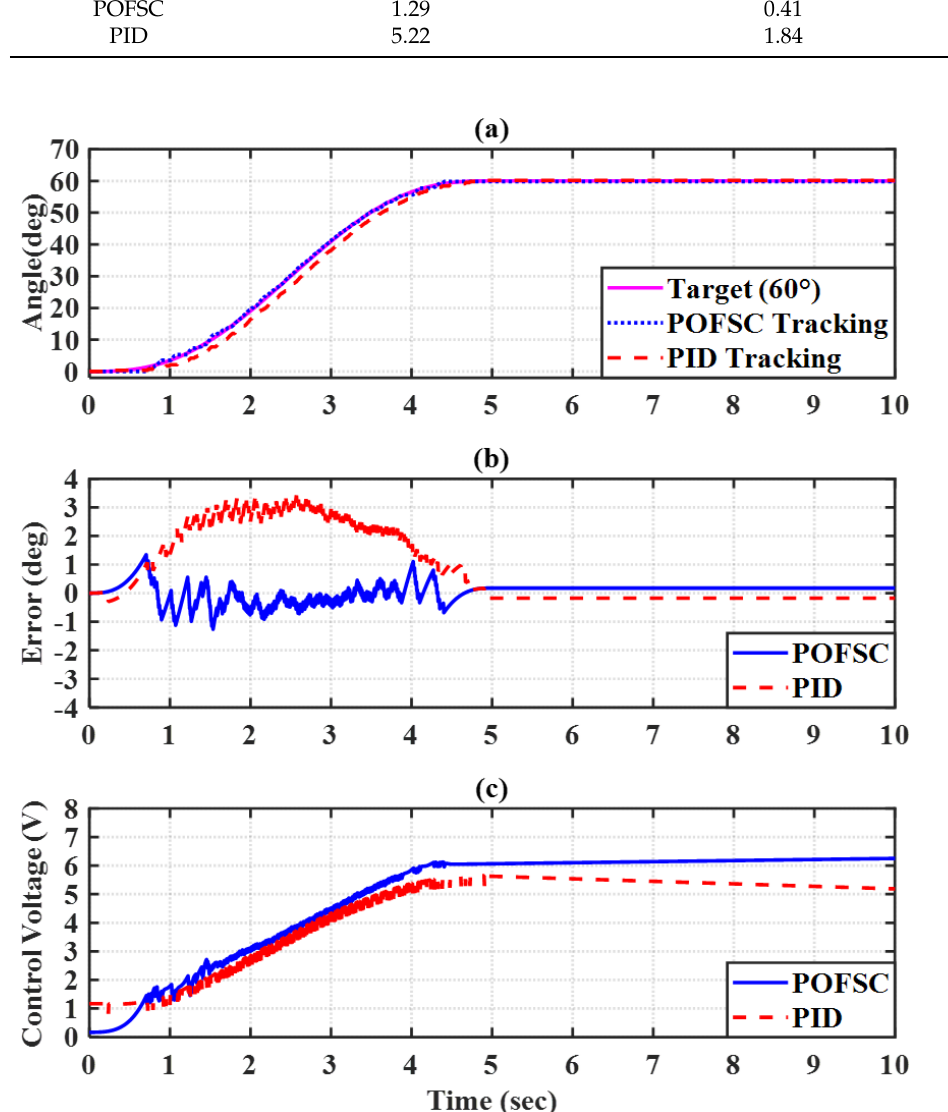
Figure 17. Comparison of fifth-order path-tracking between the POFSC and PID for the elbow joint flexion angle of 60°. ( a ) System response, ( b ) tracking error, and ( c ) control voltage.